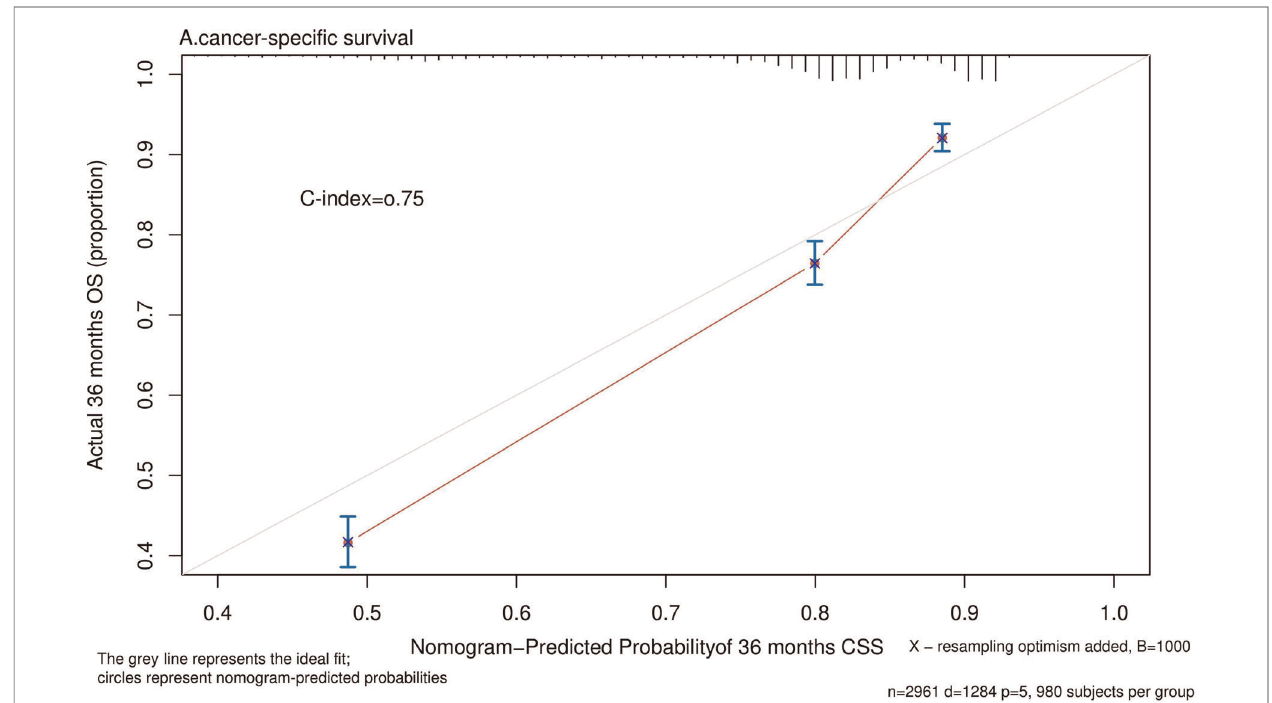
FIGURE 5 | Calibration plot comparing predicted and actual survival probability at 36 months follow-up.